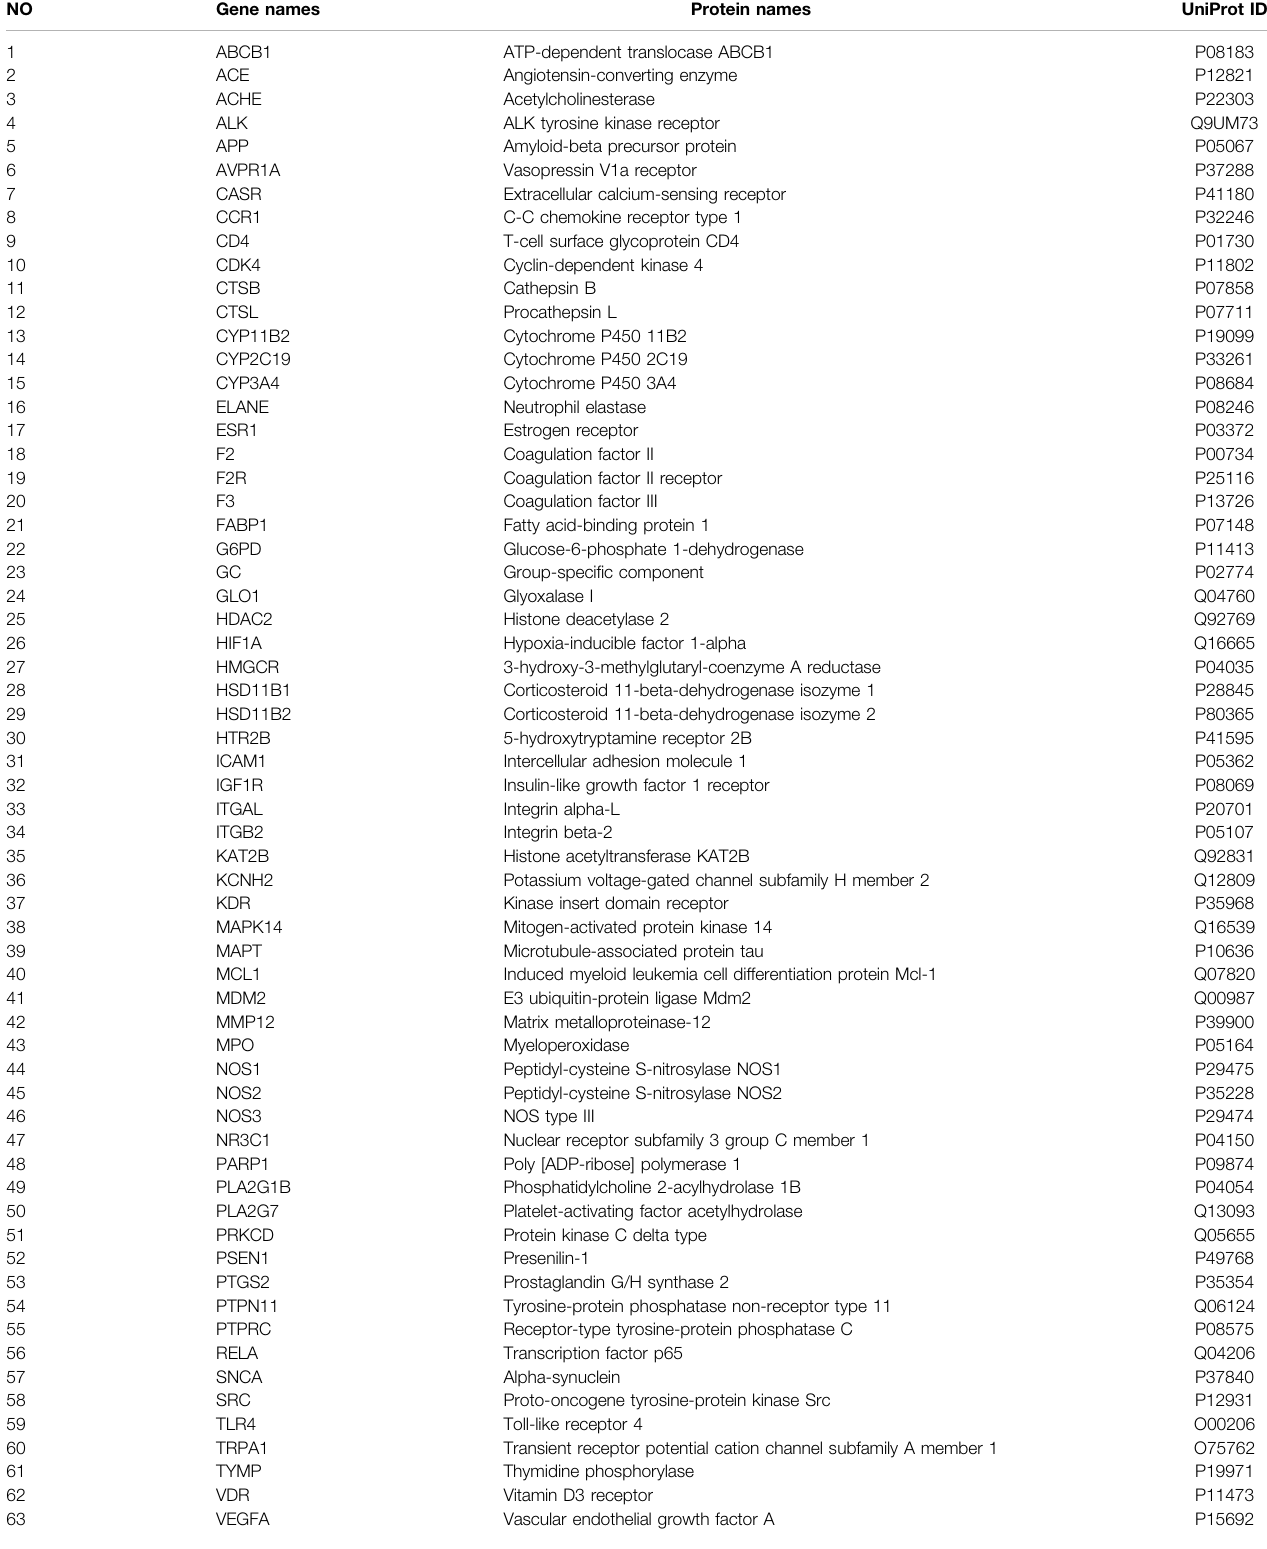
TABLE 2 | 63 intersecting targets and UniProt